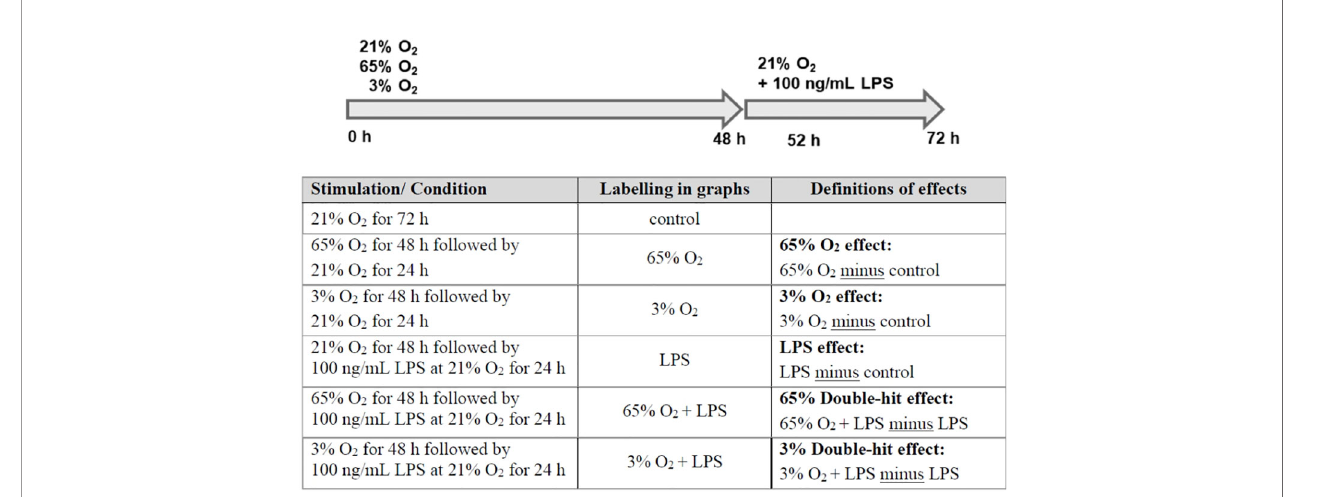
FIGURE 1 | Sequential double-hit model for lung in fl ammation. Monocyte-derived macrophages were incubated for 48 h in different O 2 concentrations (21% atmospheric O 2 , 3% O 2 , or 65% O 2 ). Subsequently, cells were removed from the different O 2 conditions and stimulated with 100 ng/mL LPS for 4 h (52 h time point) or 24 h (72 h time point) in atmospheric O 2